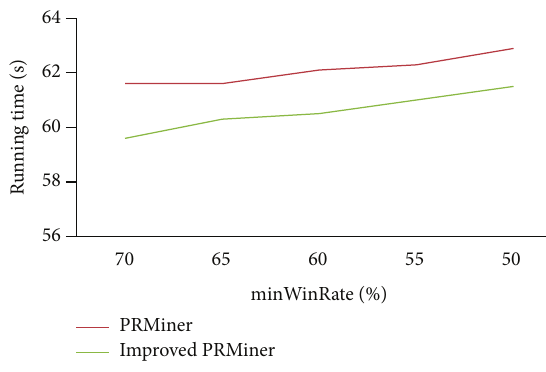
Figure 8: Performance comparison for various minWinRates.